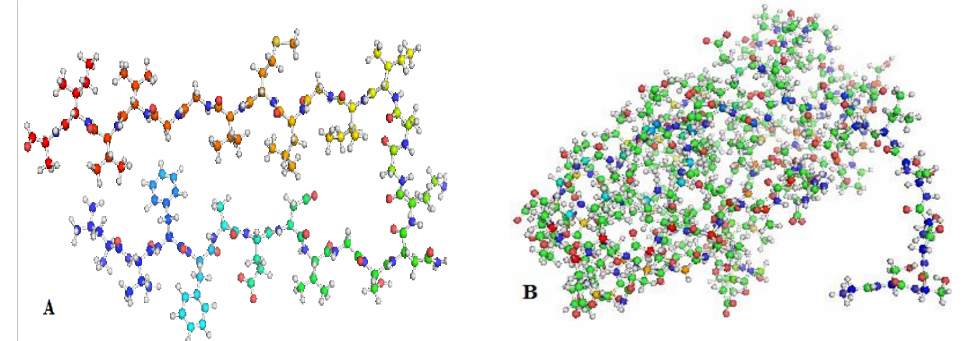
Figure 4. The three dimensional structures of the protein. ( A ) β -Amyloid (PDB ID: 2BEG). ( B ) Receptor for advanced glycation end products (RAGE) (PDB ID: